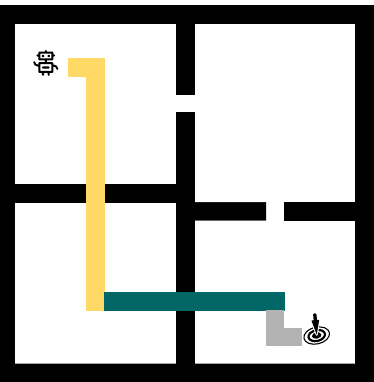
Figure 9. Example four-room gridworld. The agent needs to navigate through the different rooms in order to reach a goal-state. Navigation between rooms in this example is done by the yellow and green sub-behaviors. In order to reach the goal state, the agent also needs to use primitive actions, which are displayed in